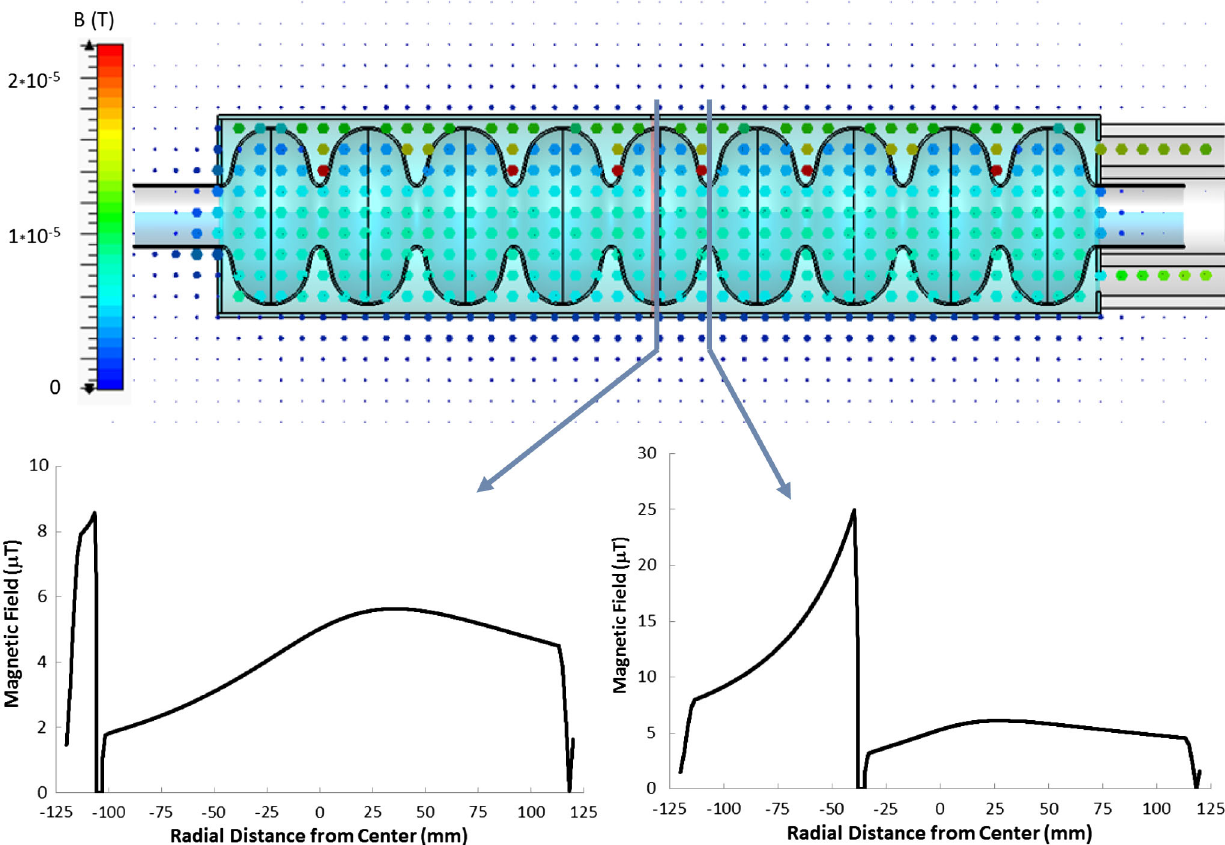
FIG. 14. Results of the asymmetric calculation, where the lower portion of the cavity is assumed to be superconducting while the upper half remains normal conducting. Again, the upper graph shows the 3-D field configuration which now is asymmetric, too. The z -axis- cuts (bottom, equator cut on the left, iris data on the right) reveal a significant amount of magnetic flux inside the cavity which at transition to superconductivity of the upper half is susceptible to pinning and as a result increasing the surface